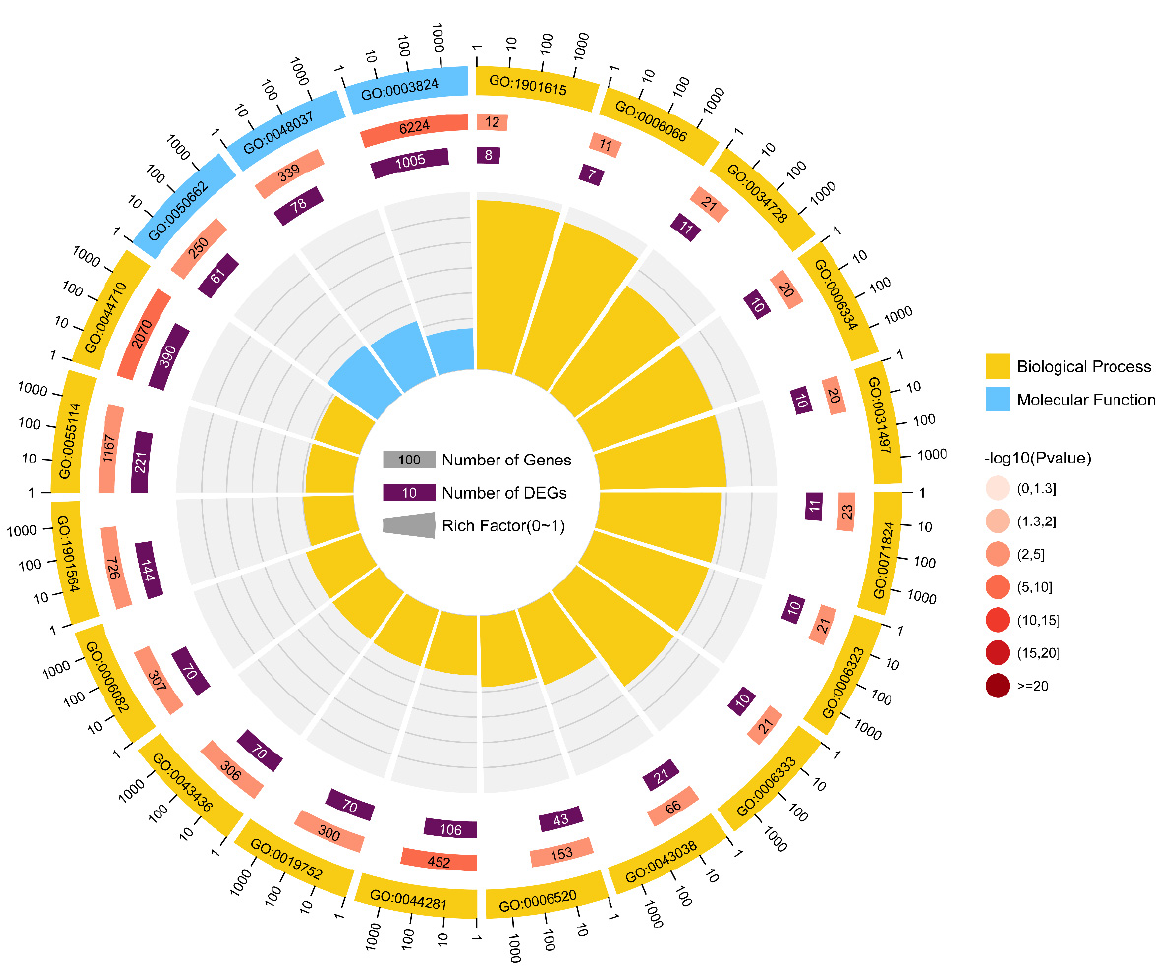
Figure 3. GO enrichment analysis of significant genes identified by RNAseq. The count number inside the orange-red and purple box represents the number of genes and DEGs enriched in a process, respectively, and the color represents the range of the p -value.